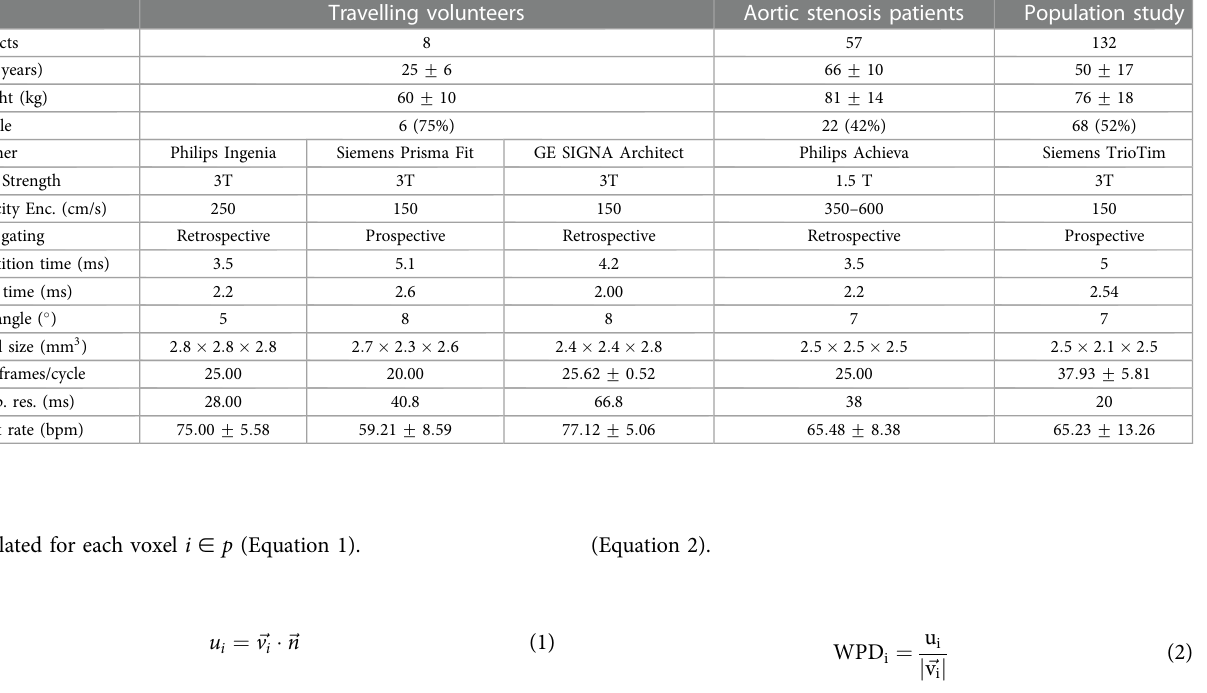
TABLE 1 Overview of the demographic and imaging properties of datasets used for the reproducibility (travelling volunteers) and applicability analyses (aortic stenosis patients and population study). Travelling volunteers Aortic stenosis patients Population